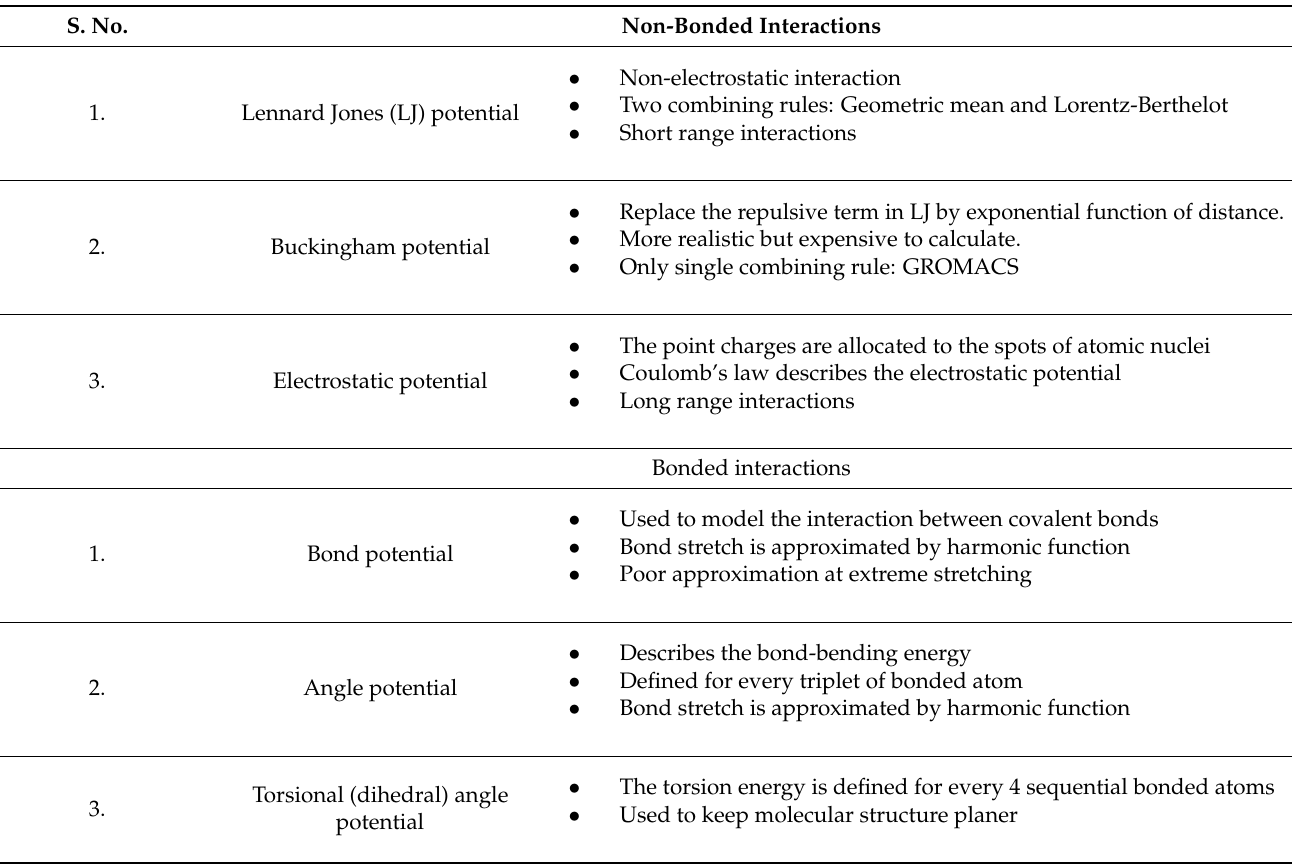
Table 6. The different potential interactions in the simulation of molecular dynamics.